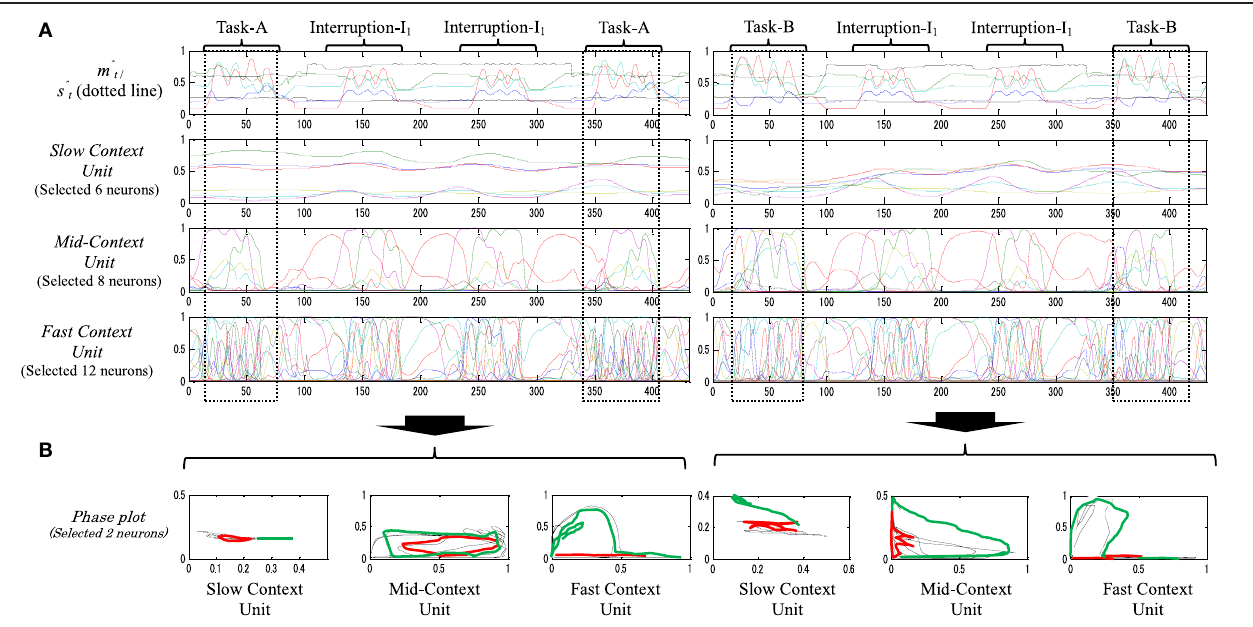
FIGURE 8 | (A) An example of behavior sequences and neural activities of a dynamic-type memory while performing task-A [Task-A → I 1 × 2 → Task-A (left)] and task-B [Task-A → I 1 × 2 → Task-A (left)], with two sequences of the task interruptions-I 1 B. Their phase plots (B) . In the phase plot, red plots illustrate task interruption part;